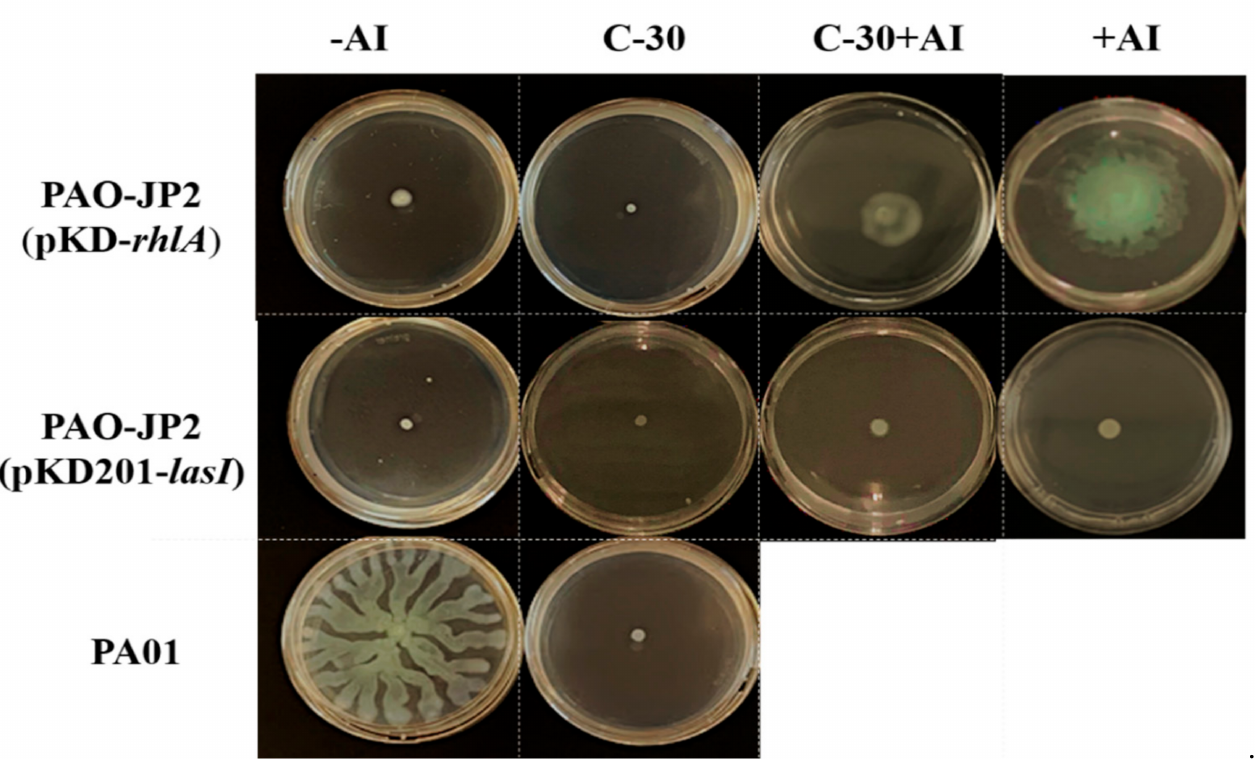
Figure 2. Images of P. aeruginosa motility in the presence and absence of autoinducers and furanone C-30. − AI indicates the absence of an autoinducer. +AI indicates the presence of an autoinducer. C-30 represents furanone C-30. The autoinducer for PAO-JP2 (pKD201- lasI ) and PAO-JP2 (pKD- rhlA ) were 3-oxo-C12-HSL and C4-HSL,